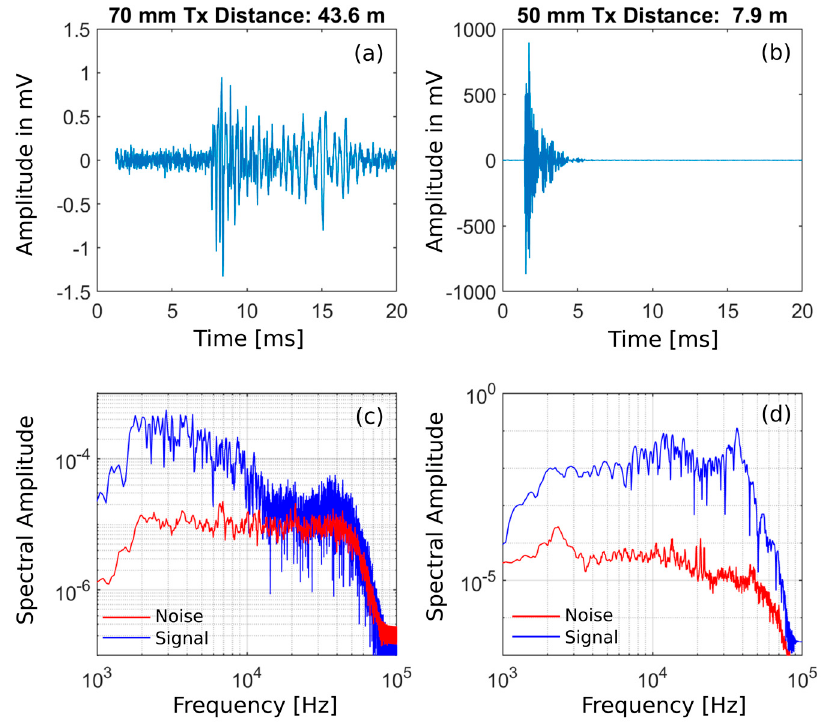
Figure 11. Data of example ultrasonic transmitters in BRP. In ( a ) the raw waveform recording of transmitter signal GMuG-Tr70 over 43.6 m distance is shown (1738 stacks). The corresponding spectrum is shown in ( c ). In ( b ), the waveform of transmitter GMuG-Tr50 over 7.9 m distance is shown (1524 stacks). The corresponding spectrum is shown in ( d ). Due to intrinsic damping, higher frequencies are transmitted for short distances only. In ( d ), frequencies above 70 kHz are visible, whereas in ( c ) only frequencies up to 15 kHz are recorded above the noise floor.